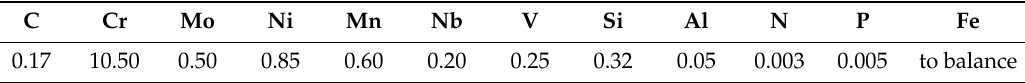
Table 1. Chemical composition of the investigated Cr martensitic steel (wt.%).